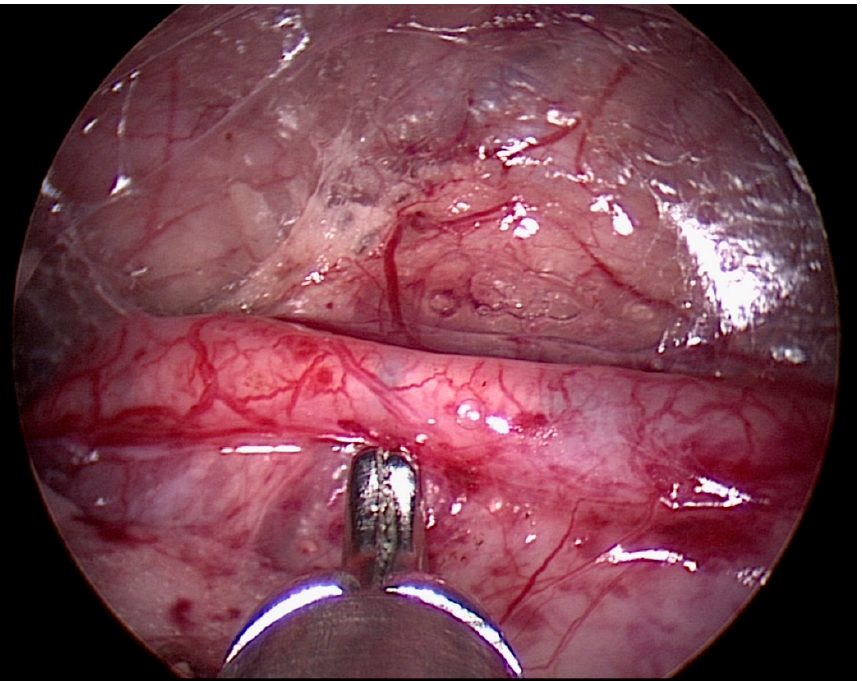
Figure 1. Ureter identification during the retroperitoneoscopic phase. The L dissector, inserted in the operative channel of the operative telescope, can be seen.